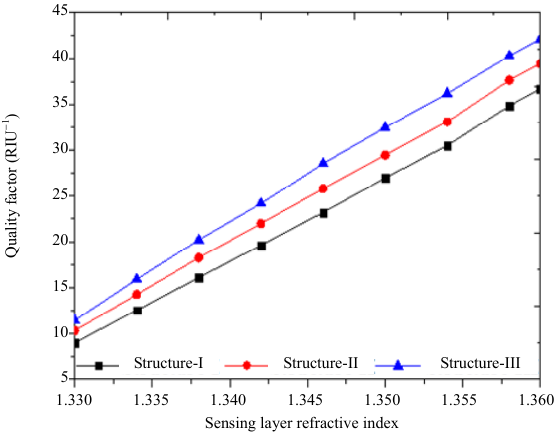
Fig. 5 Variation of the quality factor as a function of the sensing layer’ refractive indices for structure-I, structure-II, and structure-III.